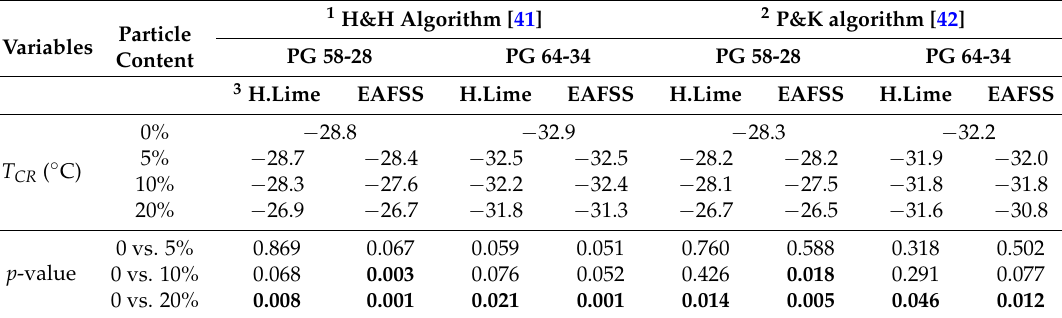
Table 2. T CR comparison